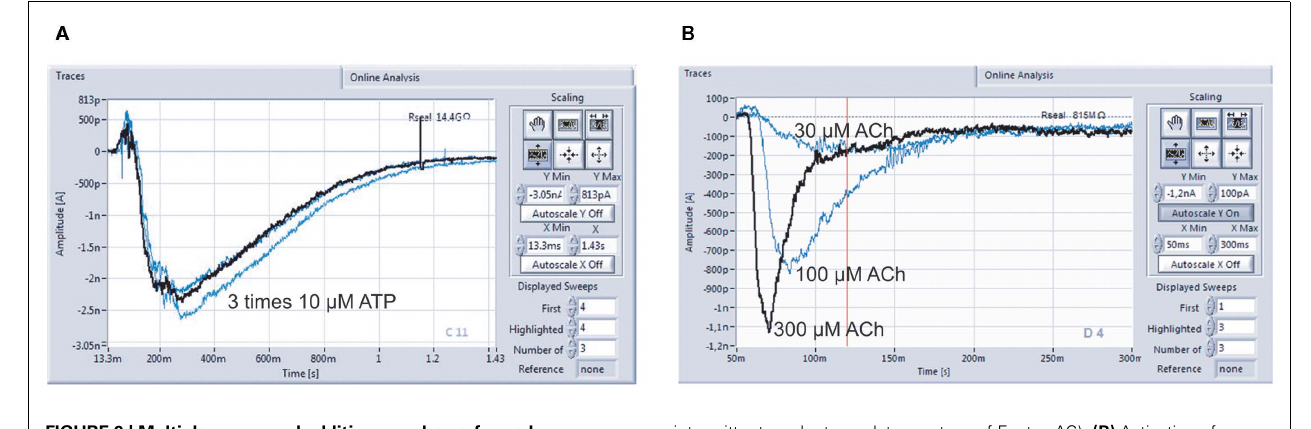
intermittent wash steps; data courtesy of Evotec AG). (B) Activation of nicotinic α 7 receptors with 30, 100, and 300 μ M Ach in one cell. Cells stably expressing human nAChRs were kindly provided by Galantos Pharma GmbH.